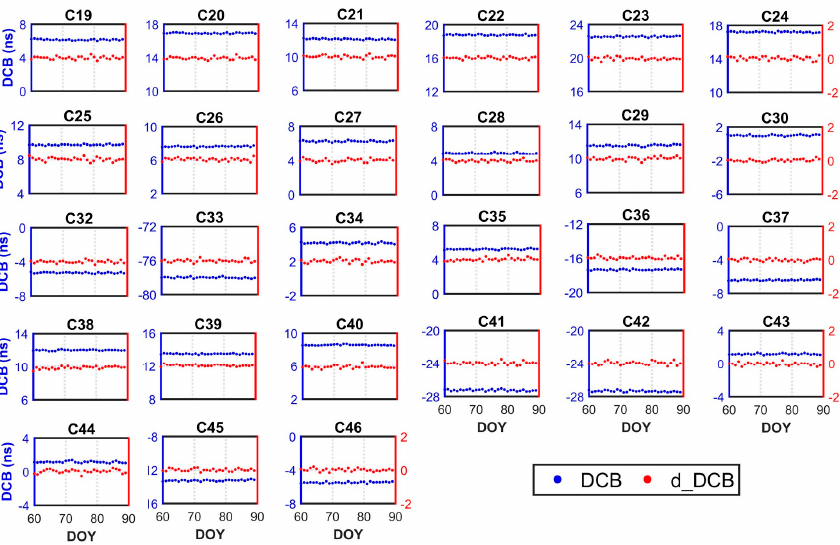
Figure 5. DCB time series of BDS-3 C1P-C5P during a period of 30 days, and the differences time series with respect to CAS products.